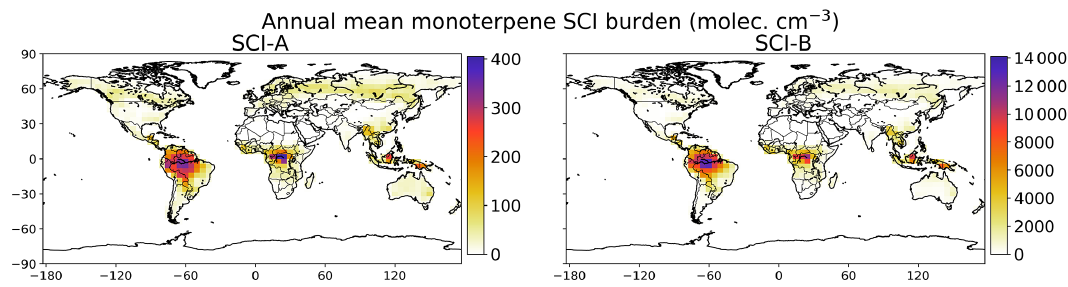
Figure 7. Annual mean monoterpene SCI-A and SCI-B concentrations (cm − 3 ) in the surface layer of the GEOS-Chem